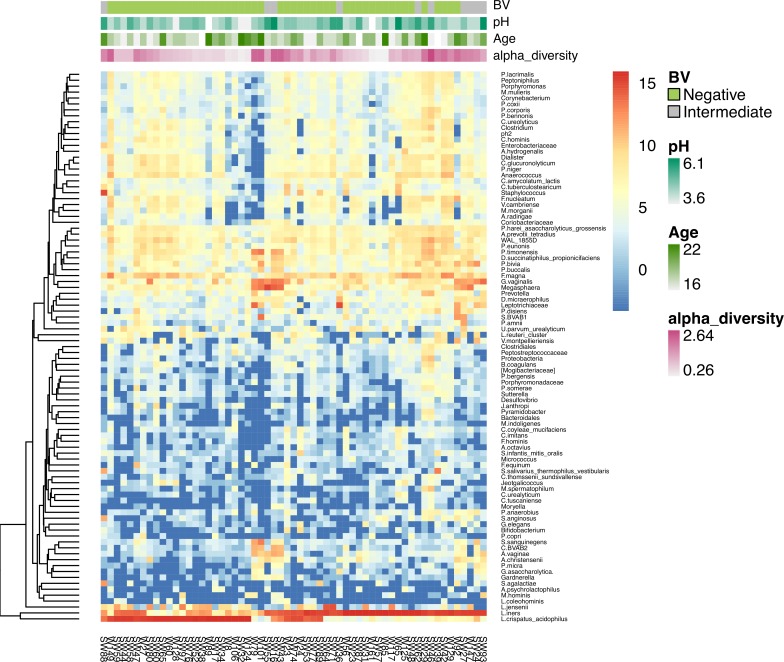
Unsupervised hierarchical clustering of bacteria merged at lowest taxa in the genital tract of young women.The top of the figure shows clustering according to BV status (light green: negative; grey: intermediate), vaginal pH (blue green), age (darker green) and alpha diversity (pink).